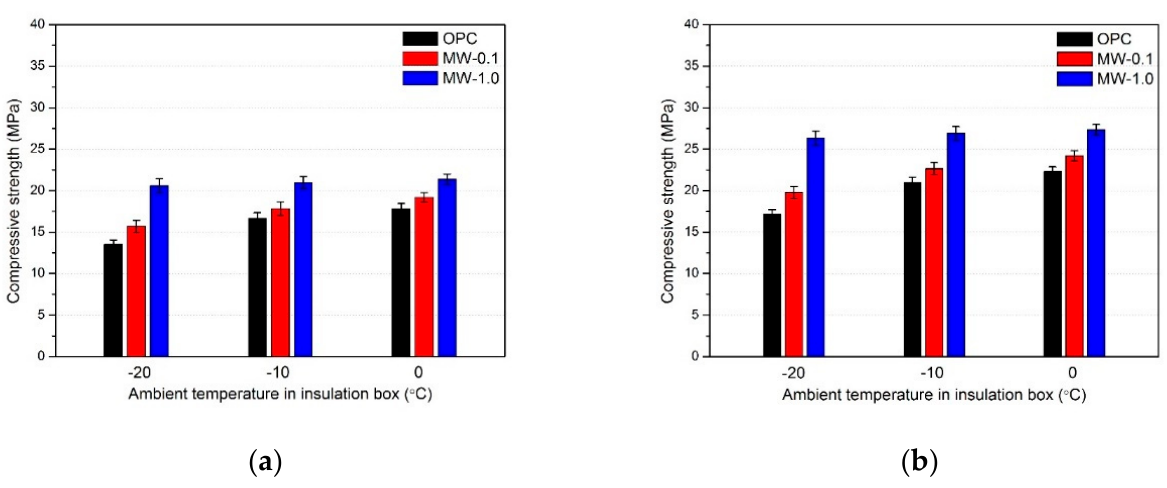
Figure 10. Compressive strength of the specimens with the insulation box after ( a ) 7 days and ( b ) 28 days.